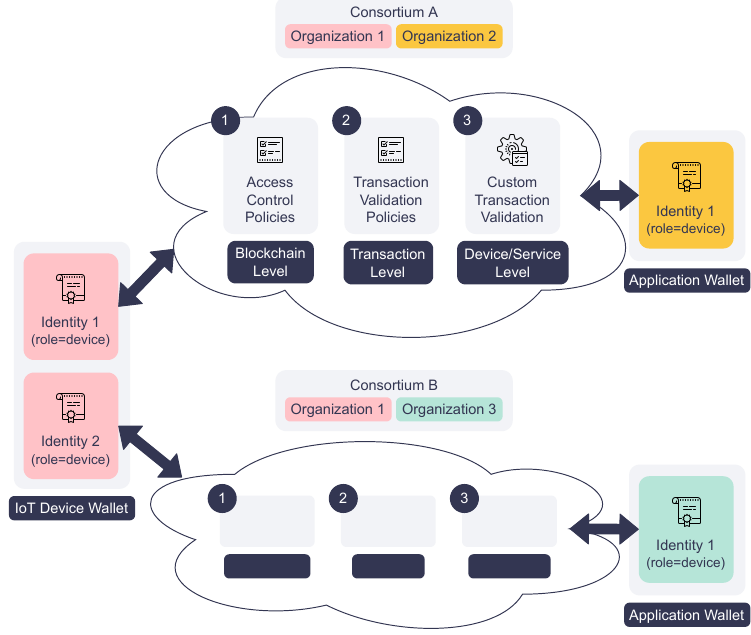
Figure 3. The proposed multi-layered access control model.